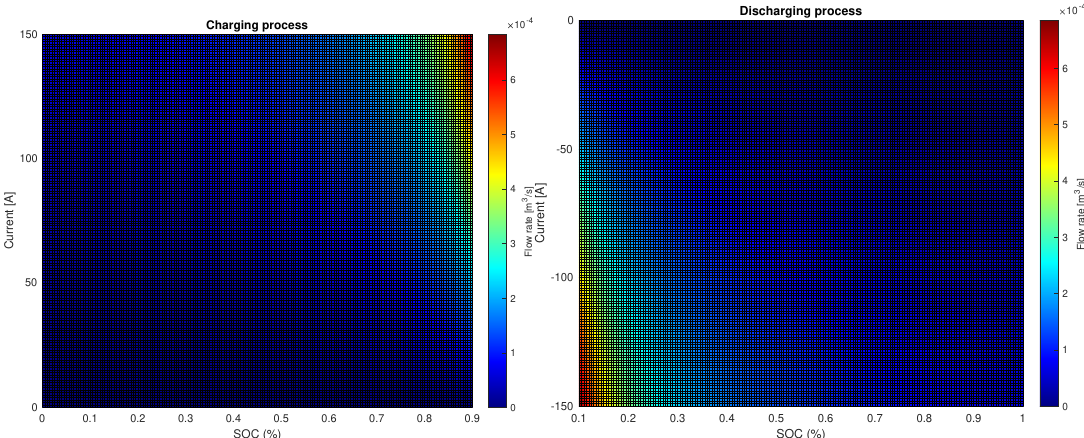
Figure 4. Minimum flow rate profiles for charging ( left ) and discharging ( right )